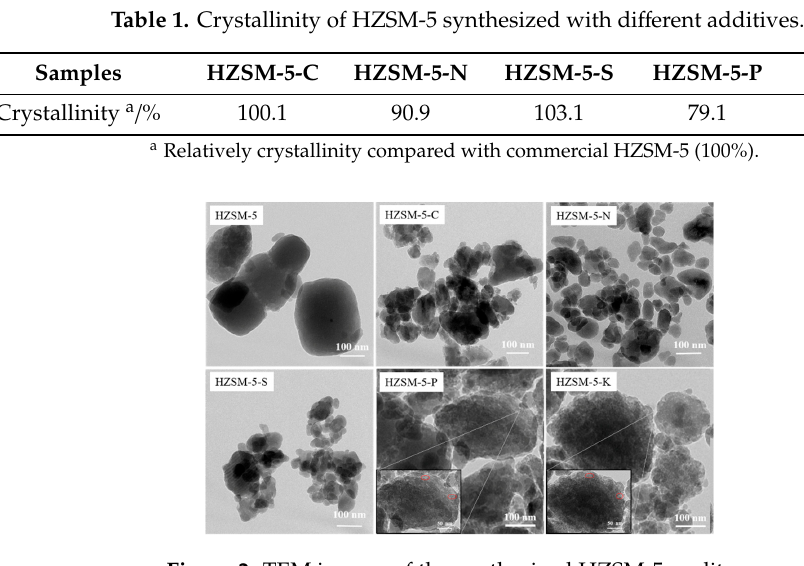
Figure 2. TEM images of the synthesized HZSM-5 zeolites.